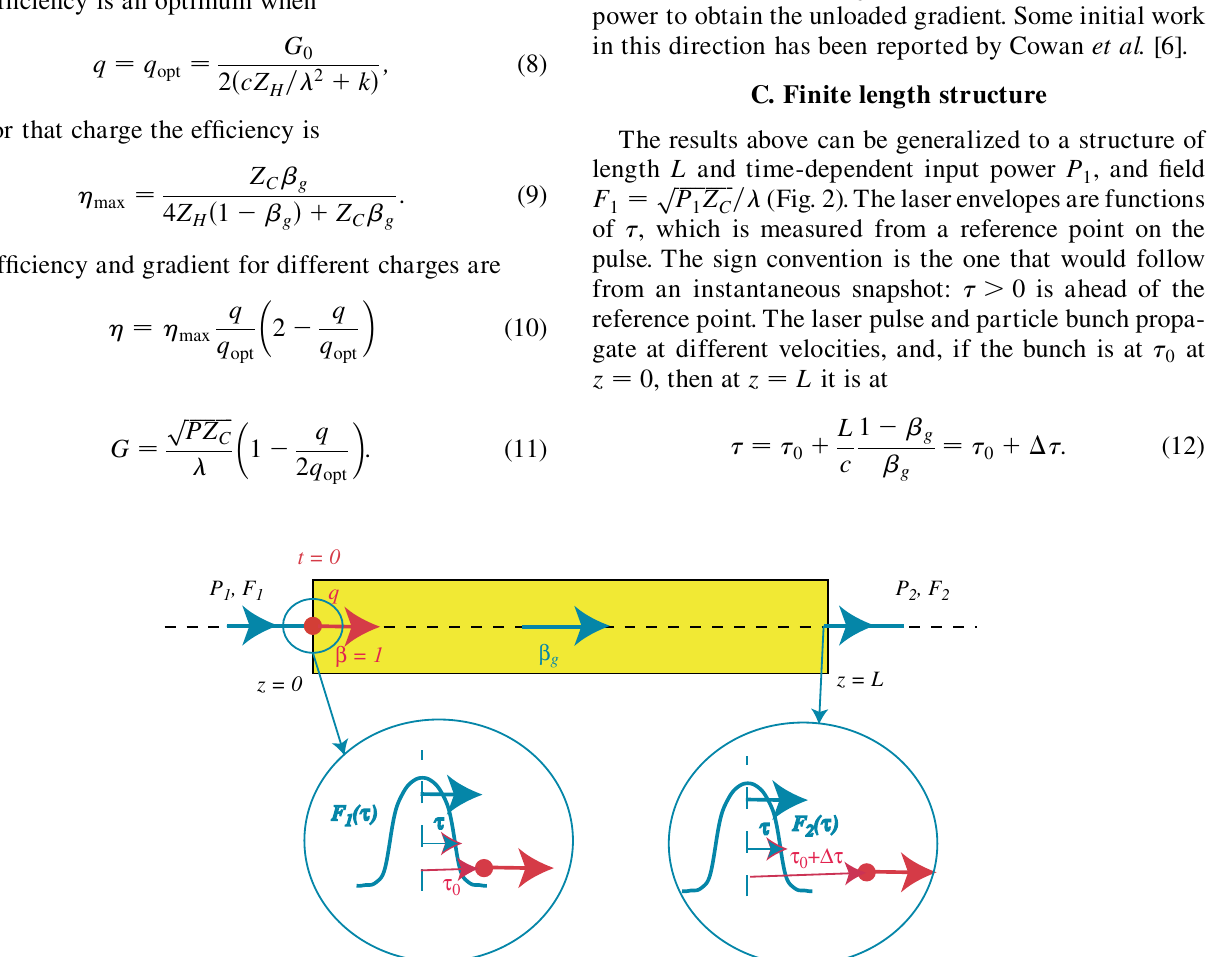
and P are the input and output power in the accelerating 1 2 (cid:6) (cid:29) (cid:24) ahead at z (cid:1) L . The group velocity of (cid:9) 0